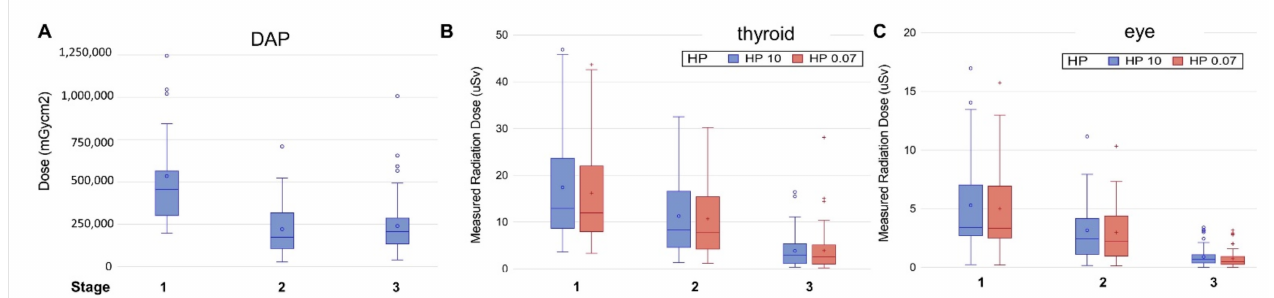
Figure 2. The distribution of ( A ) radiation output during PCI, ( B ) received radiation dose on neck (thyroid), and ( C ) right eye (lens) in stages 1, 2, and 3. ( Stage 1 : frame rate of 15 frames/second, without protection; Stage 2 : 7.5 frames/second, without protection; and Stage 3 : 7.5 frames/second, with protection; DAP : Dose Area